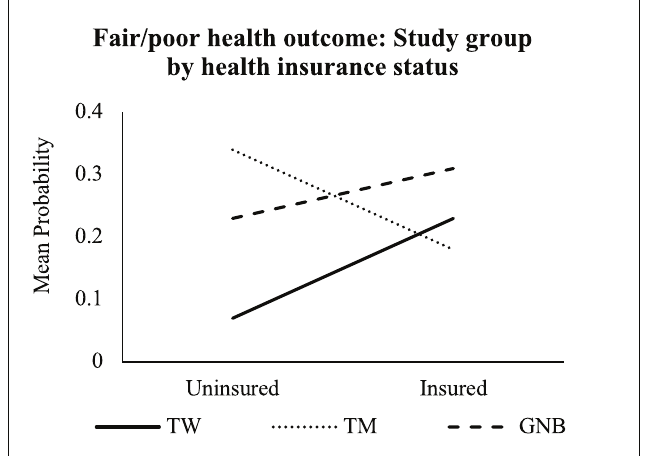
Fig 1. Final multivariable model results: Significant study group interaction for the fair/poor health outcome. GNB: gender nonbinary adults; TM: transgender men; TW: transgender